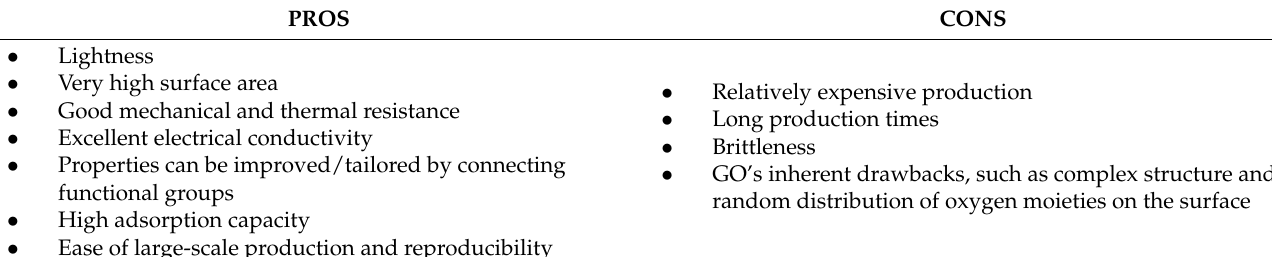
Table 3. Advantages and disadvantages of GO-based